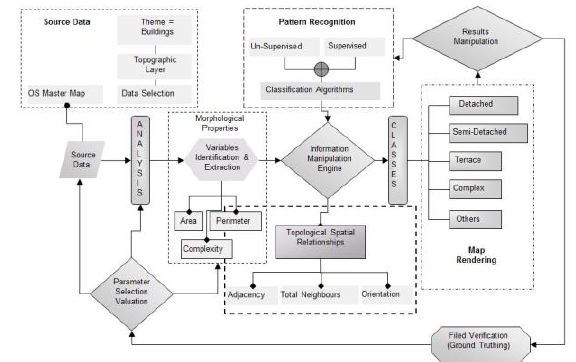
Figure 2. Level 1 Buildings classification model